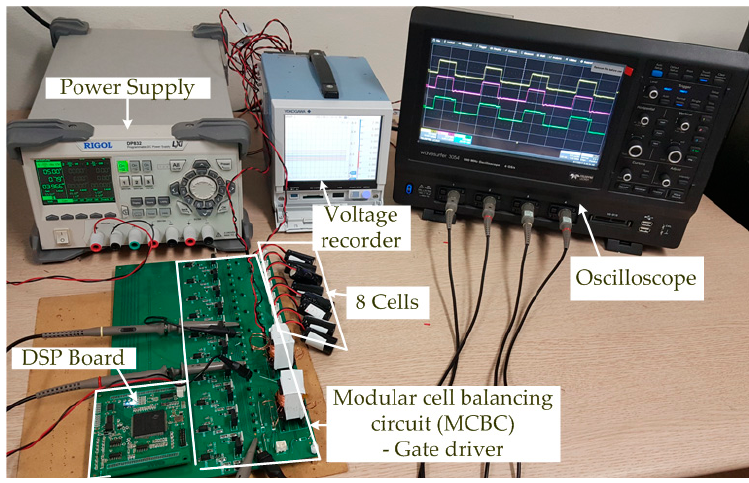
Figure 11. A prototype of the modular cell balancing circuit and experimental setup.